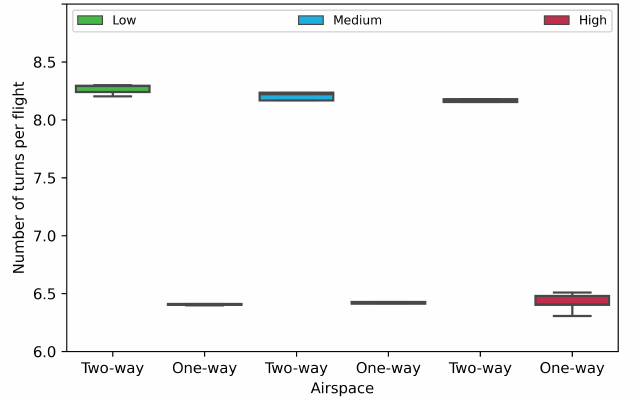
Figure 11. The number of turns per cumulative flight-plan for the two-way and one-way urban airspace